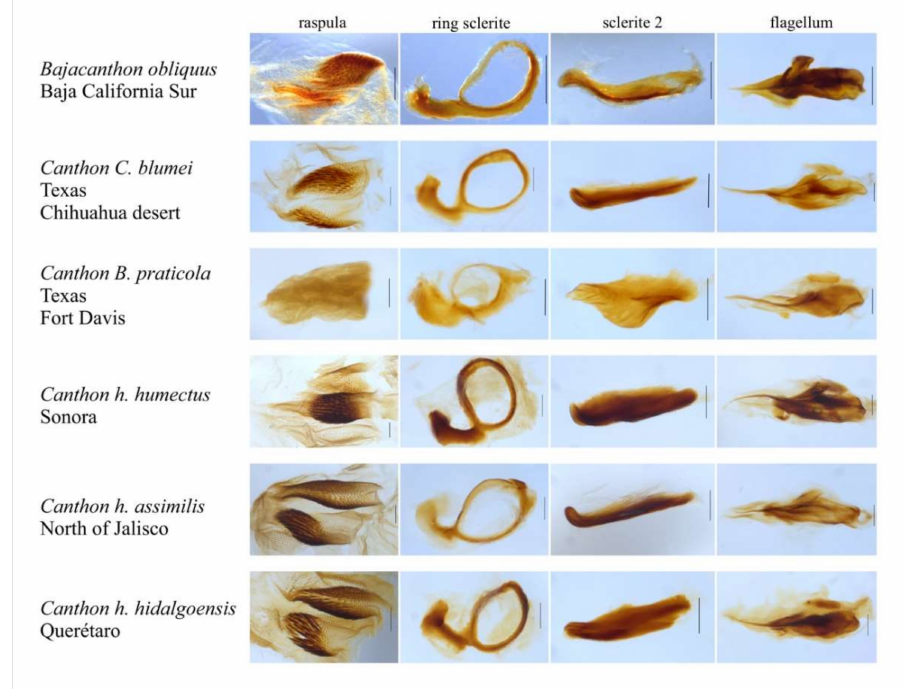
Figure 6. Comparative anatomy of the endophallus of Canthon ( Bajacanthon ) obliquus with related taxa of Deltochilini. Scale = 0.2